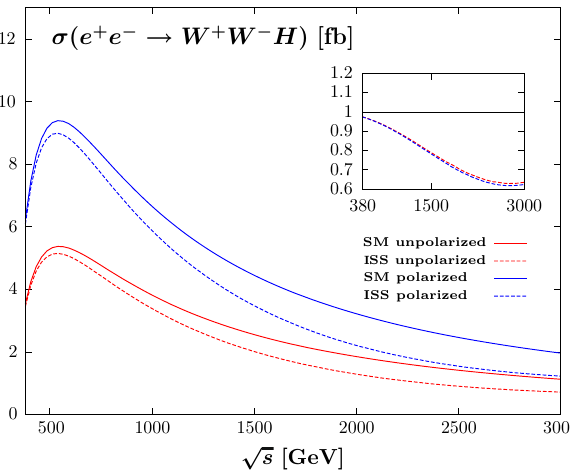
√ s (in GeV). positron collider (in fb) as a function of the c.m. energy The solid curves stand for the SM predictions, the dashed curves stand for the ISS predictions using the benchmark scenario described in the text. The red (blue) curves are for an unpolarised ( − 80% polarised electron beam) cross-section. The ratio of the ISS cross-section with respect to the SM prediction is shown in the insert = 80 . 385 GeV , M = 91 . 1876 GeV M W Z